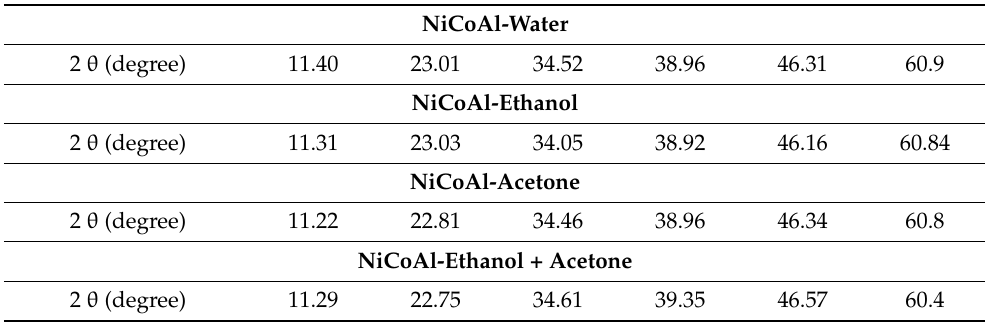
Figure 1. XRD patterns for NiCoAl-Water, NiCoAl-Ethanol, NiCoAl-Acetone, and NiCoAl- Ethanol + Acetone. Peaks at 2 θ for NiCoAl-Water, NiCoAl-Ethanol, NiCoAl-Acetone, and NiCoAl- Ethanol +